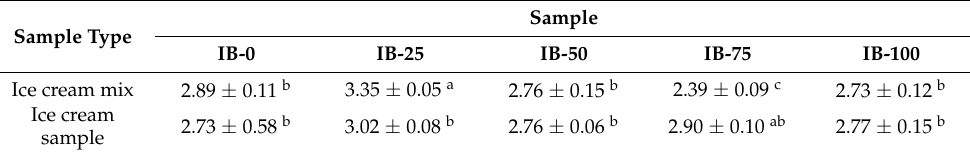
Table 3. Viable bacterial counts (log CFU g − 1 ) in ice cream incorporating